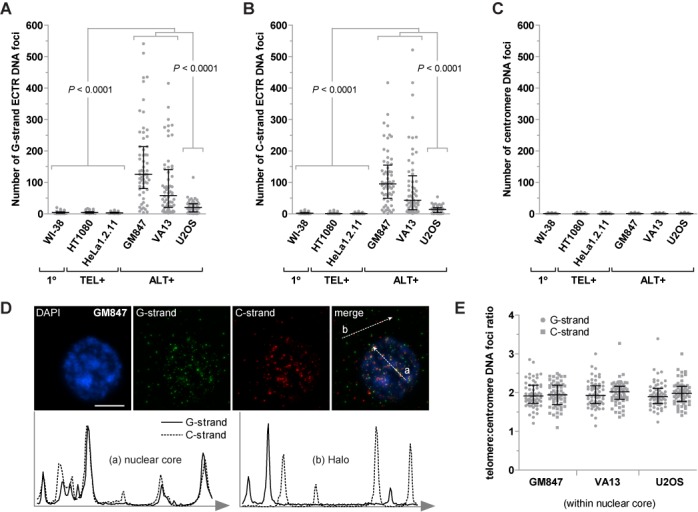
Analysis of the number of ECTR DNA molecules detected in human primary, telomerase-positive and ALT cells. The number of G-strand ECTR DNA foci per nucleus (A), the number of C-strand ECTR DNA foci per nucleus (B) and the number of centromere DNA foci per nucleus (C) located in the Halo of the deproteinized nuclei are plotted for WI-38 primary cell, HT1080 and HeLa1.2.11 telomerase-positive cells, and GM847, VA13 and U2OS ALT cells. (D) GM847 deproteinized nucleus counterstained with DAPI (blue) to visualize the nuclear core and probed for G-strand (green) and C-strand (red) telomere-repeat DNA. White arrows through the merged image indicate the direction of the intensity linescan plots. The intensity linescan plots show colocalization patterns between G- and C-strand telomere-repeat DNA signals within the (a) nuclear core and the (b) Halo of the deproteinized nucleus. Scale bar, 10μm. (E) G- or C-strand telomere to centromere DNA foci ratio per nucleus within the nuclear core of the deproteinized nuclei for GM847, VA13 and U2OS ALT cells. 1°: primary, TEL+: telomerase-positive, ALT+: ALT-positive. Median and error bars representing the interquartile range are displayed.